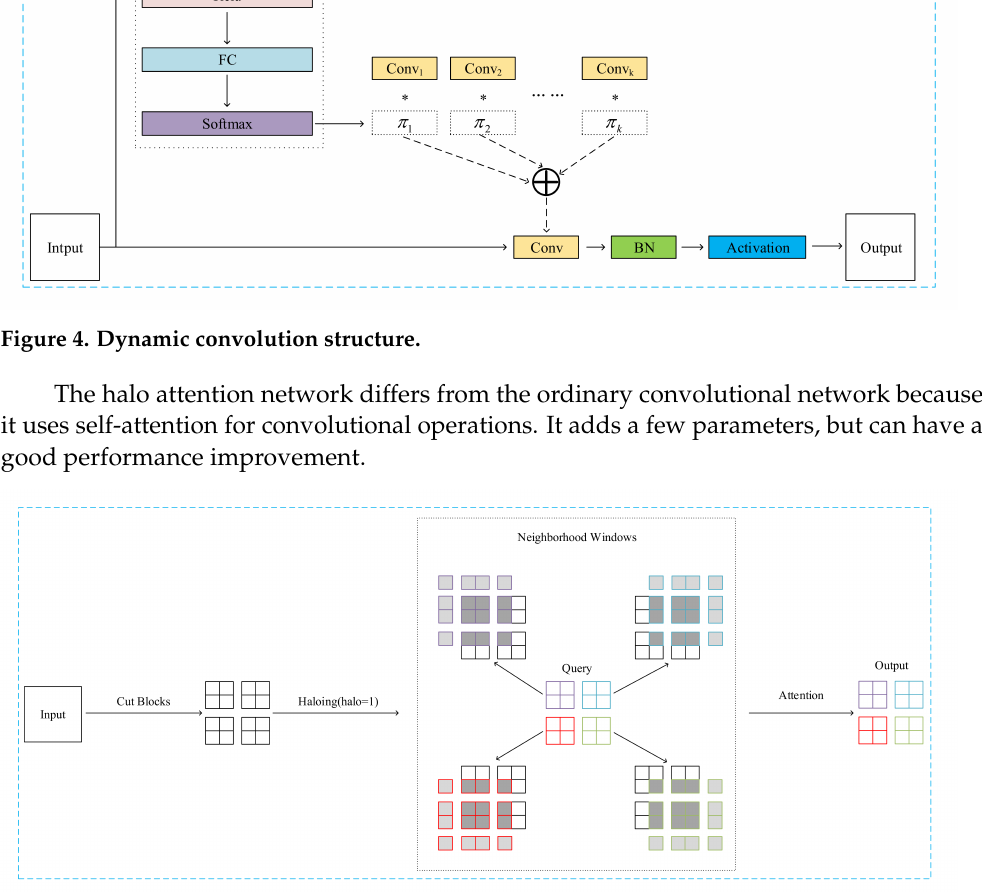
Figure 5. Halo attention structure . An image is input and subsequently divided into four blocks of the same size. Next, the query from these blocks is computed, and n layers of aperture are added outside each block by the halo operation ( n is the value of halo). Subsequently, a note operation is performed on this sampled information so as to downsample it and finally output the feature